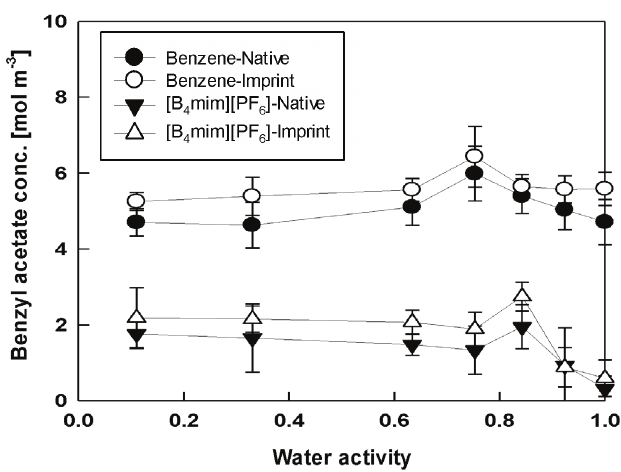
Fig. 2 – Effect of water activity on transesterification activi- ty. [VA] = [BA] = 30 mol m –3 .